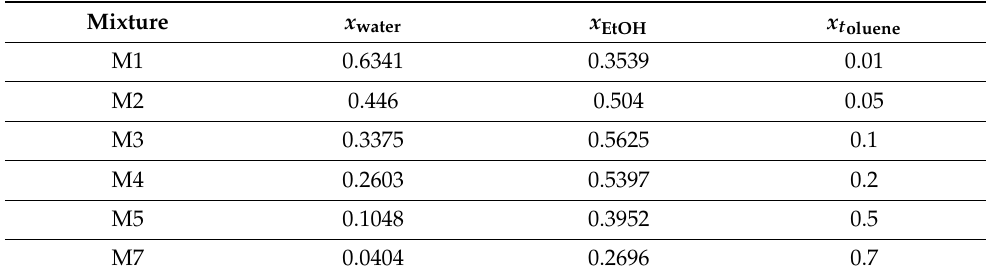
Table A1. Molar fractions of solvents: water, ethanol, and toluene used to make the ternary mixtures tested to swell PNIPAM (Figure